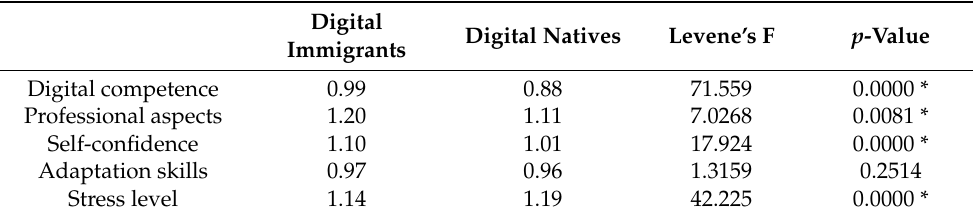
Table 9. Standard deviations of the subscales of the survey and statistics of the Levene’s test when differentiating by digital generation (deviations out of five). Digital Digital Natives Levene’s F p -Value Immigrants Digital competence 0.99 0.88